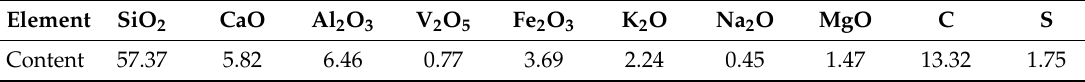
Table 1. Chemical composition analysis result of stone coal ore wt %.